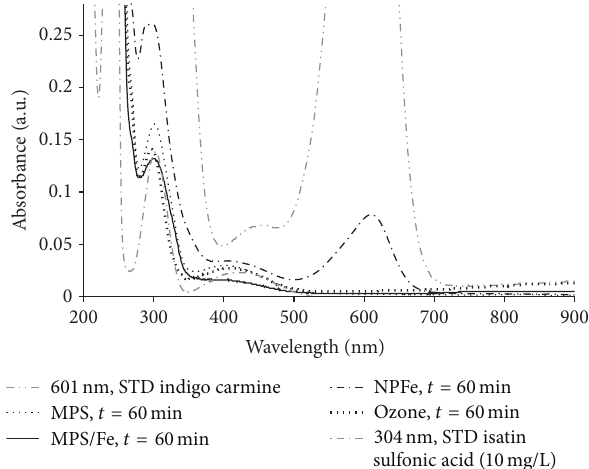
Figure 4: Effect of type of added material and time on IC concen- tration without ozone.